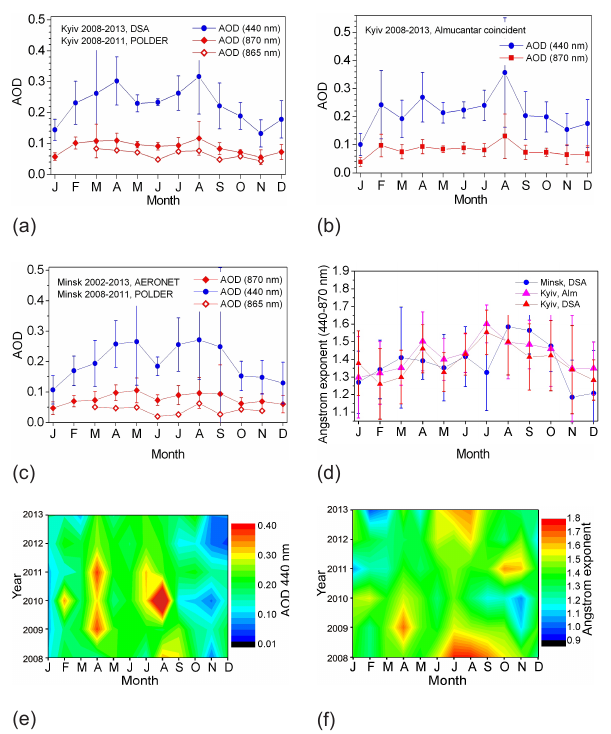
Figure 2. (a – c) The AOD (440nm) and the AOD (870nm) mean value seasonal changes by AERONET data and the AOD (865nm) by POLDER data for the Kyiv and Minsk sites, (d) the set of Ångström exponent (440–870nm) values, (e) the features of AOD (440nm), and (f) Ångström exponent (440–870nm) season varia- tions at the Kyiv site from year to year. Vertical bars show monthly mean standard deviations from averaged values. Months are shown by their first letters in the order January–December.